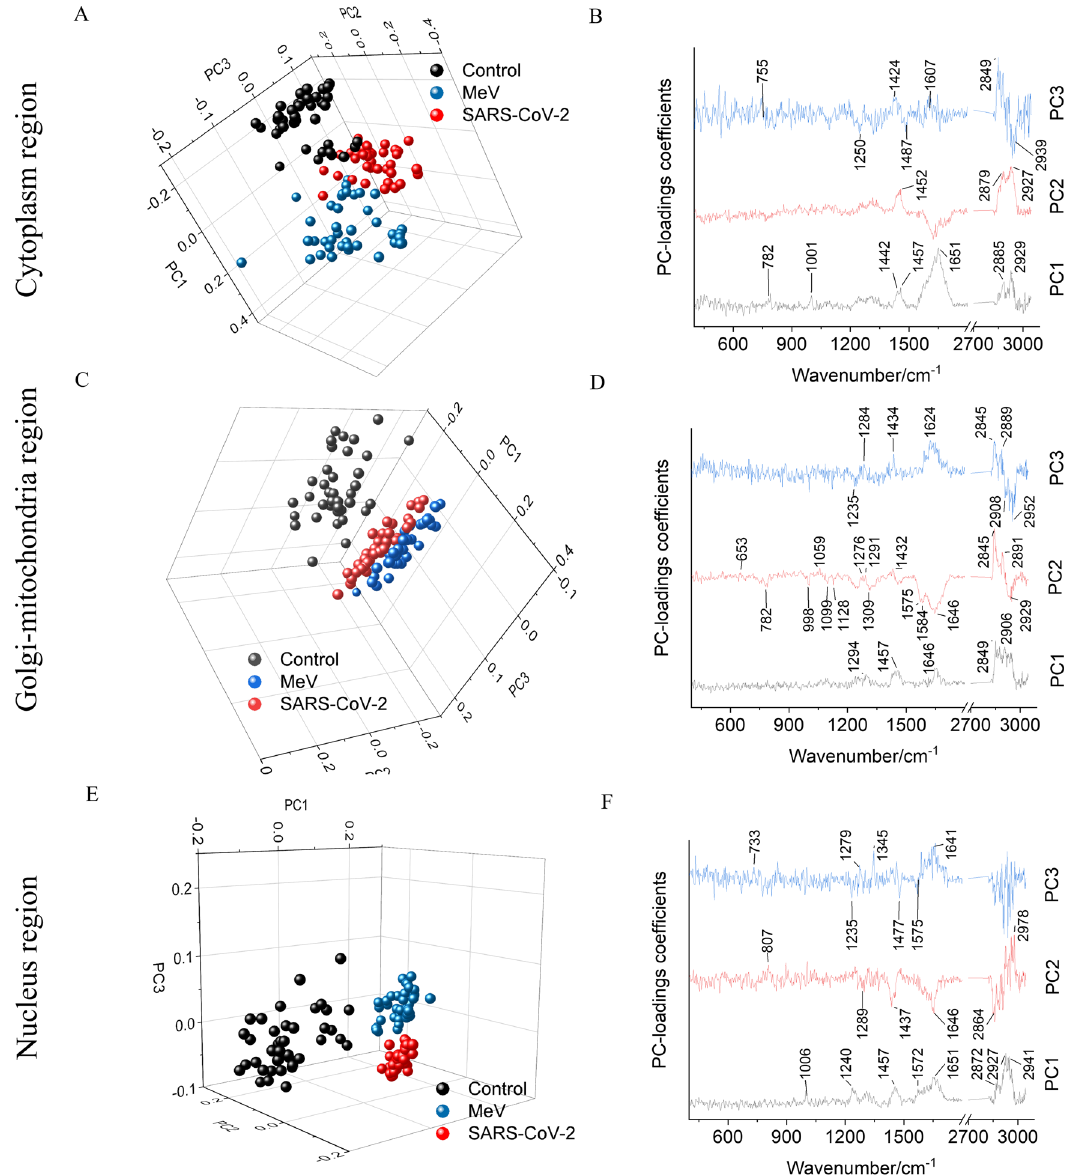
Fig. 3 Principal component analysis (PCA) of Raman spectra extracted from intracellular components of SARS-CoV-2 and MeV-infected and noninfected (Control) Vero E6 cells. 3D PCA score plot of Raman spectra from A cells ’ cytoplasm and B corresponding PC loadings, C cells ’ Golgi- mitochondria bodies, D corresponding PC loadings, E cells ’ nucleus, and F corresponding PC loadings. The loading coef fi cients are shifted on the y-axis for sake of